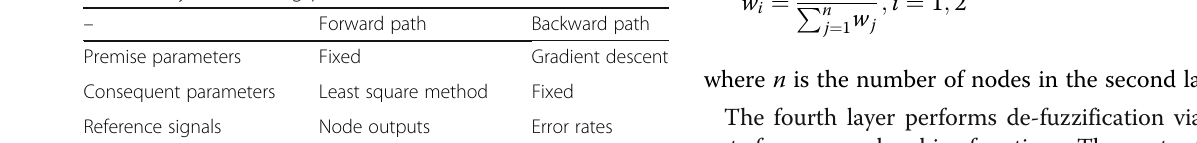
Table 1 Hybrid learning process